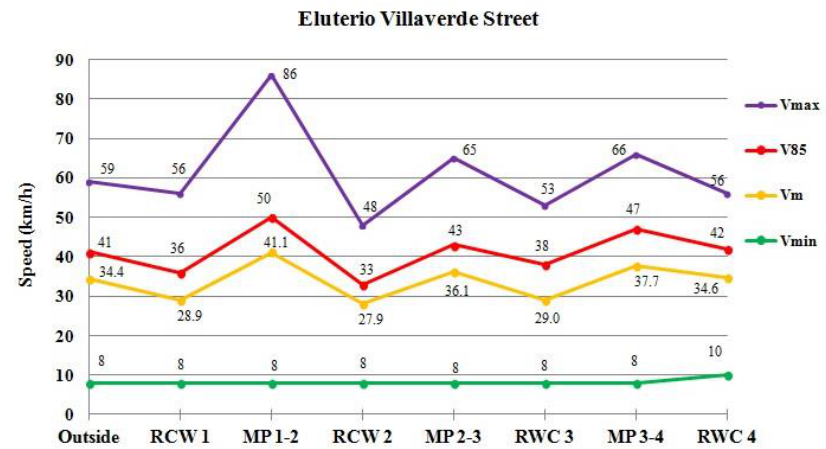
Figure 8. Speed values in the measurement points in Eluterio Villaverde Street, in Basauri (Spain).